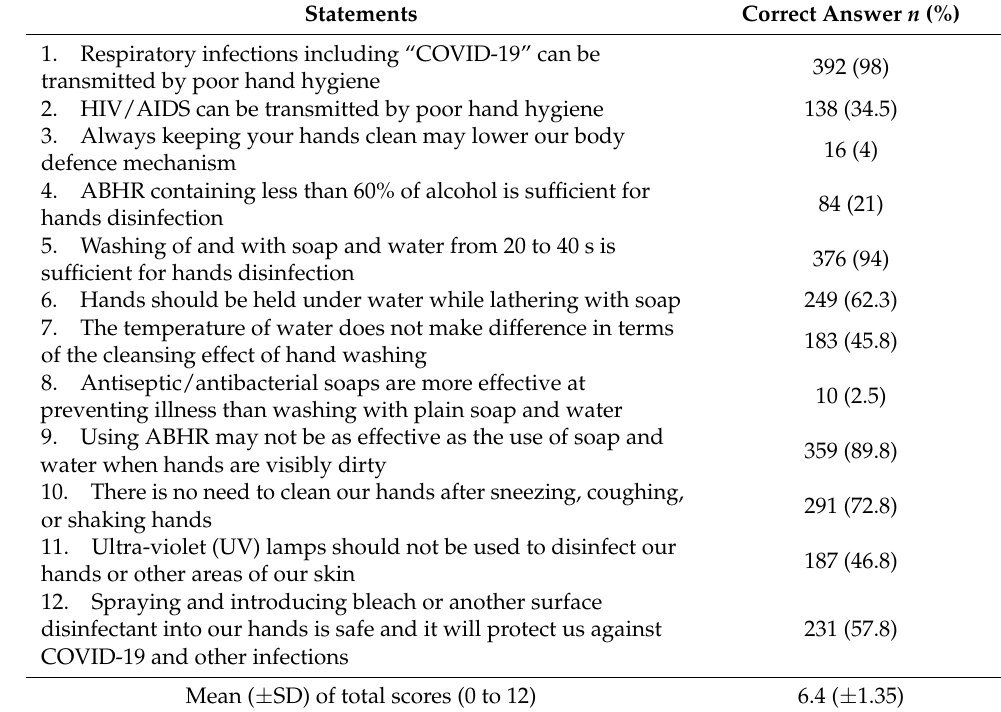
Table 2. Hand hygiene knowledge level among participants ( n = 400).